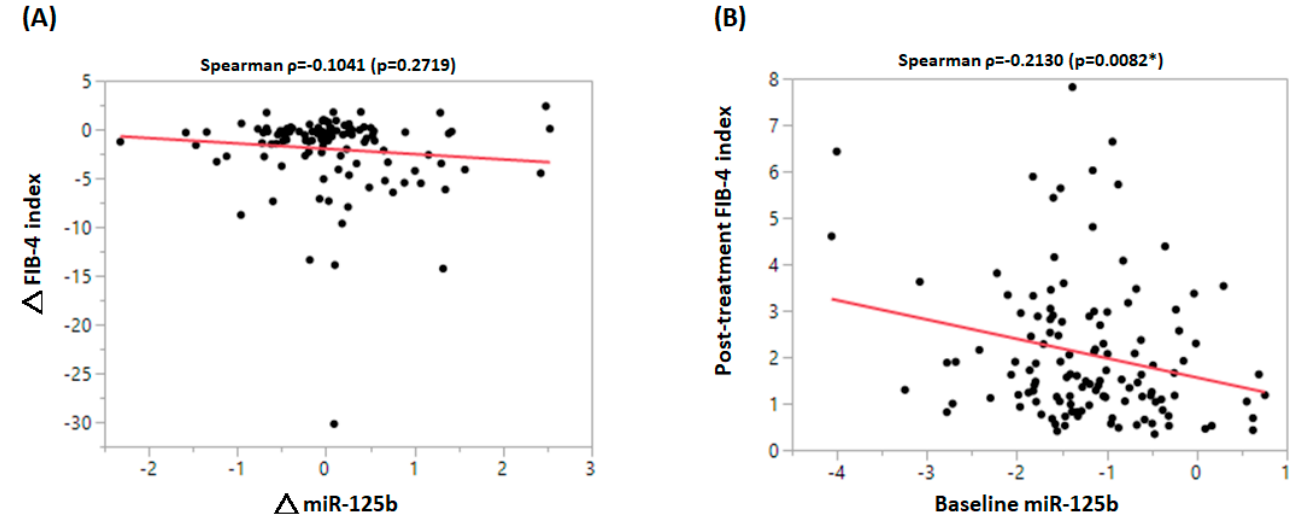
Figure 2. Linear regression analysis was used to assess the correlation between ( A ) the change in miRNA − 125b and the change in the FIB − 4 index, and ( B ) the baseline miRNA − 125b (serum miRNA − 125b, i.e., log 2ˆbaseline miR − 125b) and post-treatment FIB − 4 index. (cid:52) FIB − 4 index, 12- month FIB − 4 index; (cid:52) miRNA − 125b, log 2 − delta post − miR − 125b − log 2 − delta pre − miR − 125b . * = p <